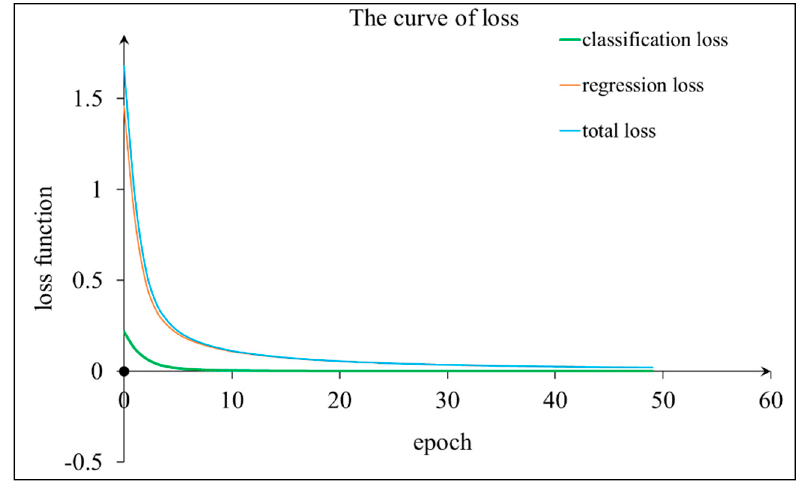
Figure 6. Curves of classification loss (green line), regression loss (orange line), and total loss (light blue line) as a function of epoch.